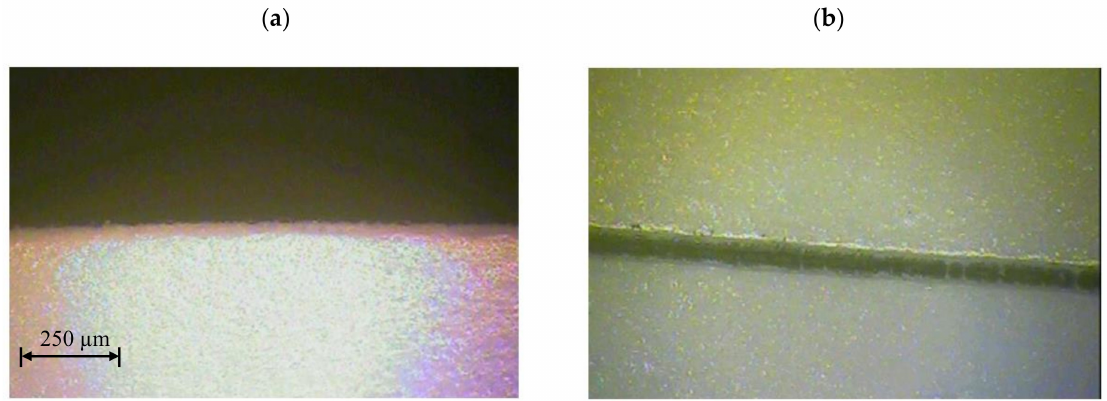
Figure 6. View of the cut surface of foil with thickness t = 60 µ m: ( a ) v = 0.222 m / s, f = 39 kHz, ( b ) v = 1.28 m / s, f = 130